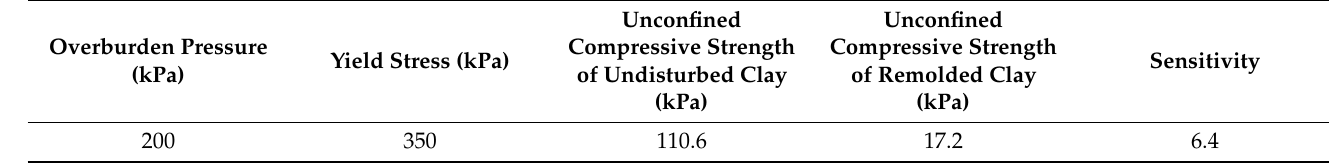
Table 2. Mechanical properties of Zhanjiang